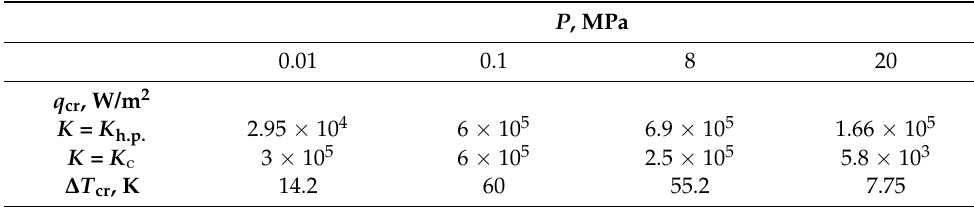
Table 1. Critical heat loads ( q cr ) and temperature head ( ∆ T cr